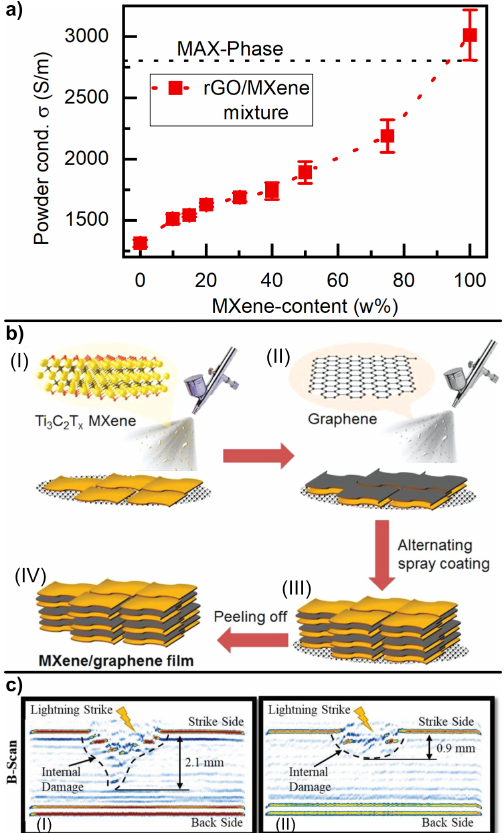
Figure 6. ( a ) Powder conductitivity of rGO/MXene mixtures against the MXene content; ( b ) applica- tion of rGO/MXene multilayered film system by alternated spray-coating: (I) spraying of Ti 3 C 2 T x MXene nanosheets, (II) spraying of rGO nanosheets, (III) production of heterogenic structure by alternate spray coating, (IV) Peel-off of the heterogenic MXene/rGO film electrode (reprinted from Zhao et al. (2019) [61] under permission from Wiley-VCH); ( c ) penetration depth evaluation following a lightning strike of an unprotected CFRP (left) and an MXene LSP-system-protected CFRP (right) (reprinted from Kumar et al. (2021) [62] under permission from